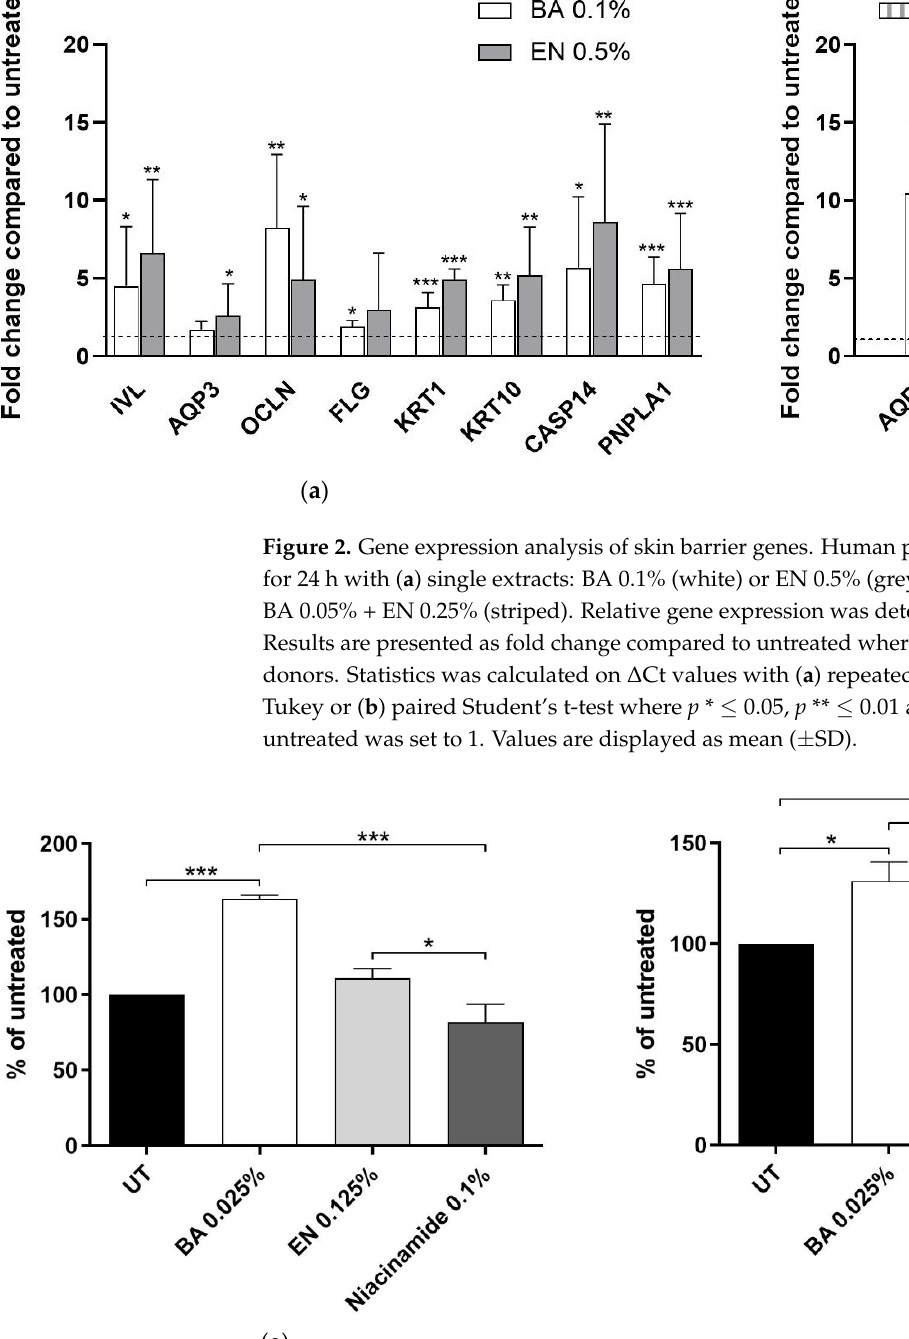
Figure 3. Protein expression of ( a ) AQP3 and ( b ) OCLN in human primary keratinocytes after 48 h treatment with BA or EN. As a reference, 0.1% niacinamide was used. Statistics was performed on normalized relative fluorescence intensity with repeated measures ANOVA and post-test Tukey where p * ≤ 0.05, and p *** ≤ 0.001. Untreated was set to 100% and n = 3 where n is the number of donors. Values are displayed as mean ( ±